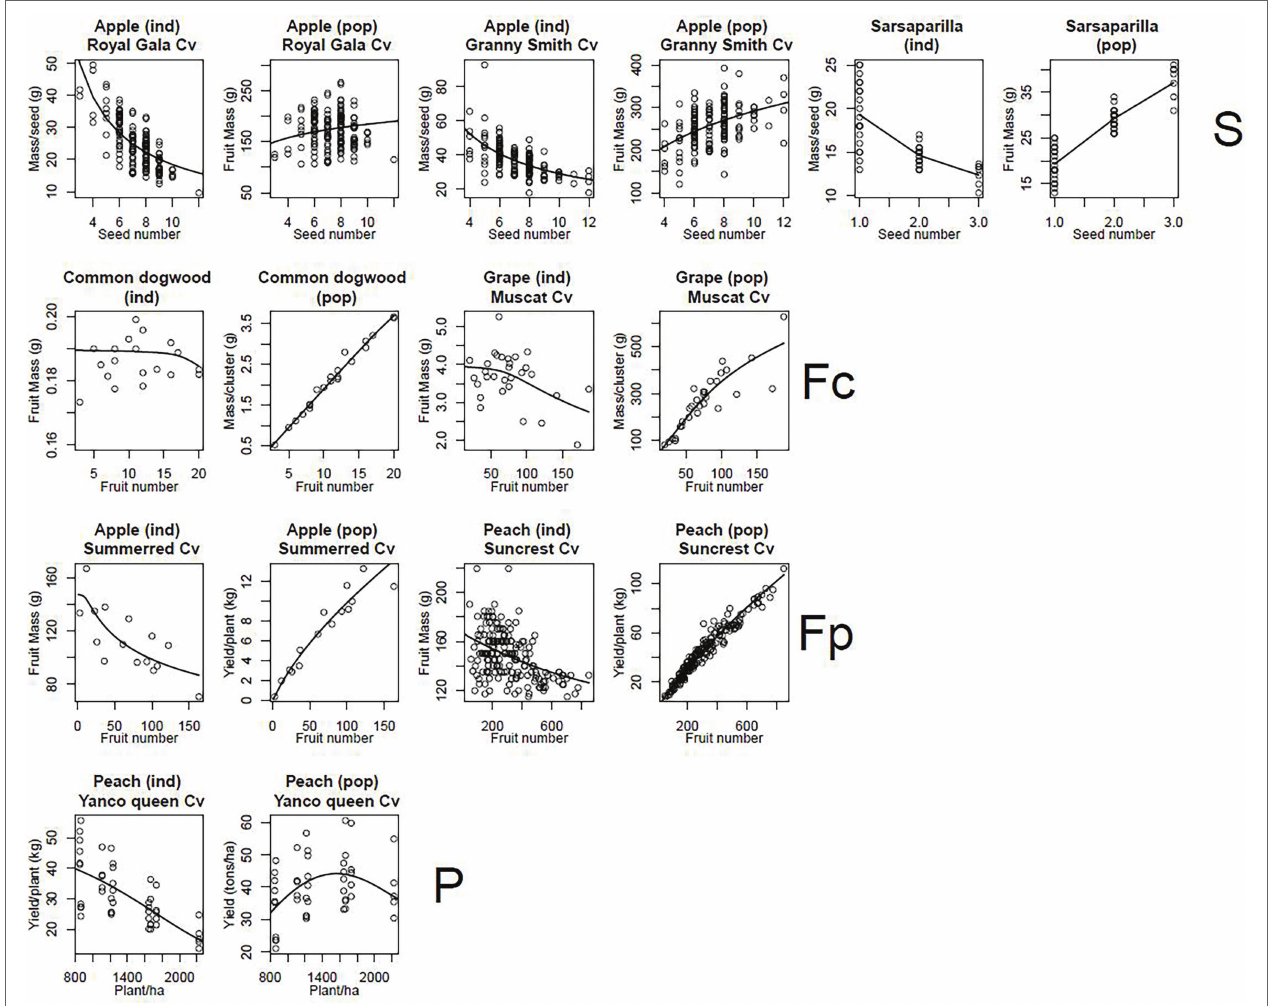
FIGURE 6 | Plots of fruit mass at fruit maturity per individual (ind) and total fruit mass of the population (pop) against number of individuals in the population. The circles correspond to experimental data and the lines are model predictions based on the parameter estimates shown in Supplementary Table 1 . The levels of organisation considered were the seed (S), the fruit in a cluster (Fc) or in a plant (Fp) and the plant (P). For each graph, the species studied is indicated, together with variety, if